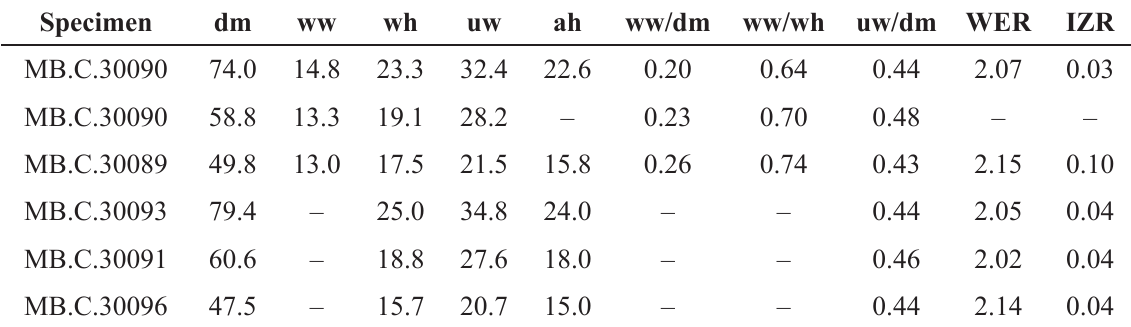
Table 35. Conch dimensions (partly estimated) and ratios of selected specimens of Stoyanowites dieneri (Stoyanow, 1910) from Baghuk